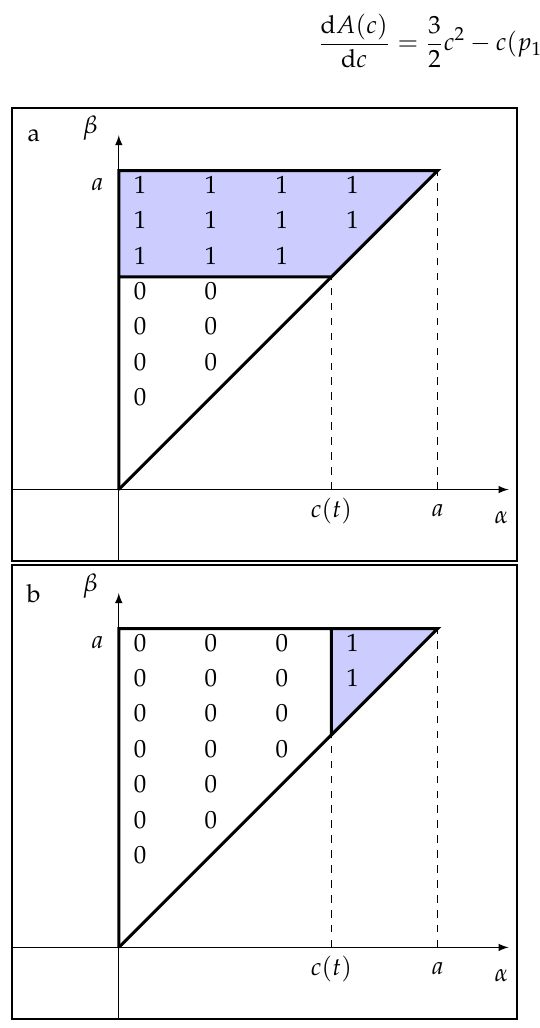
Figure 5. ( a ) The extreme value of A ( c ) when p 2 − p 1 + c > 0; ( b ) the extreme value of A ( c ) when p 2 − p 1 + c <